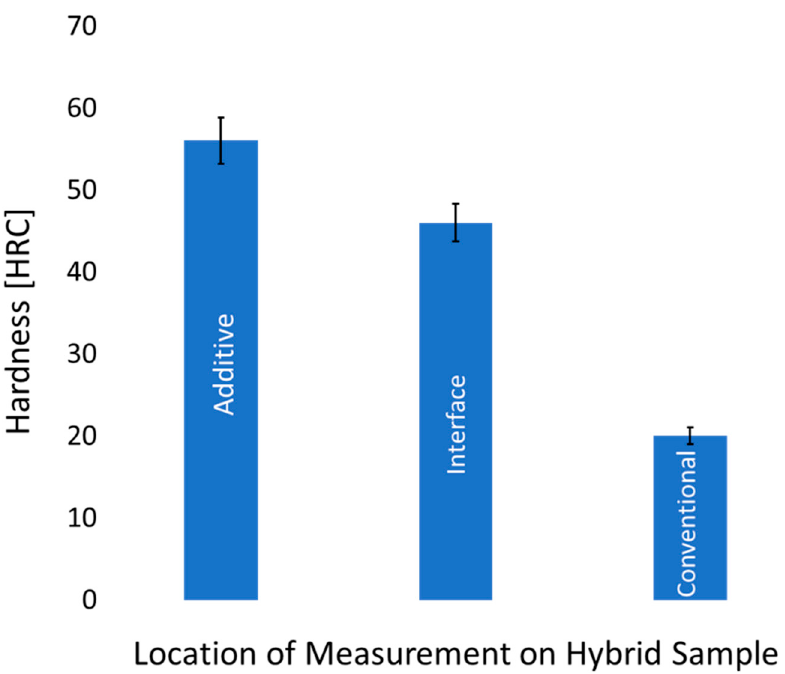
Figure 11. Microstructure of repaired sample. The microstructure of the additive cube is finer than the conventional preform.